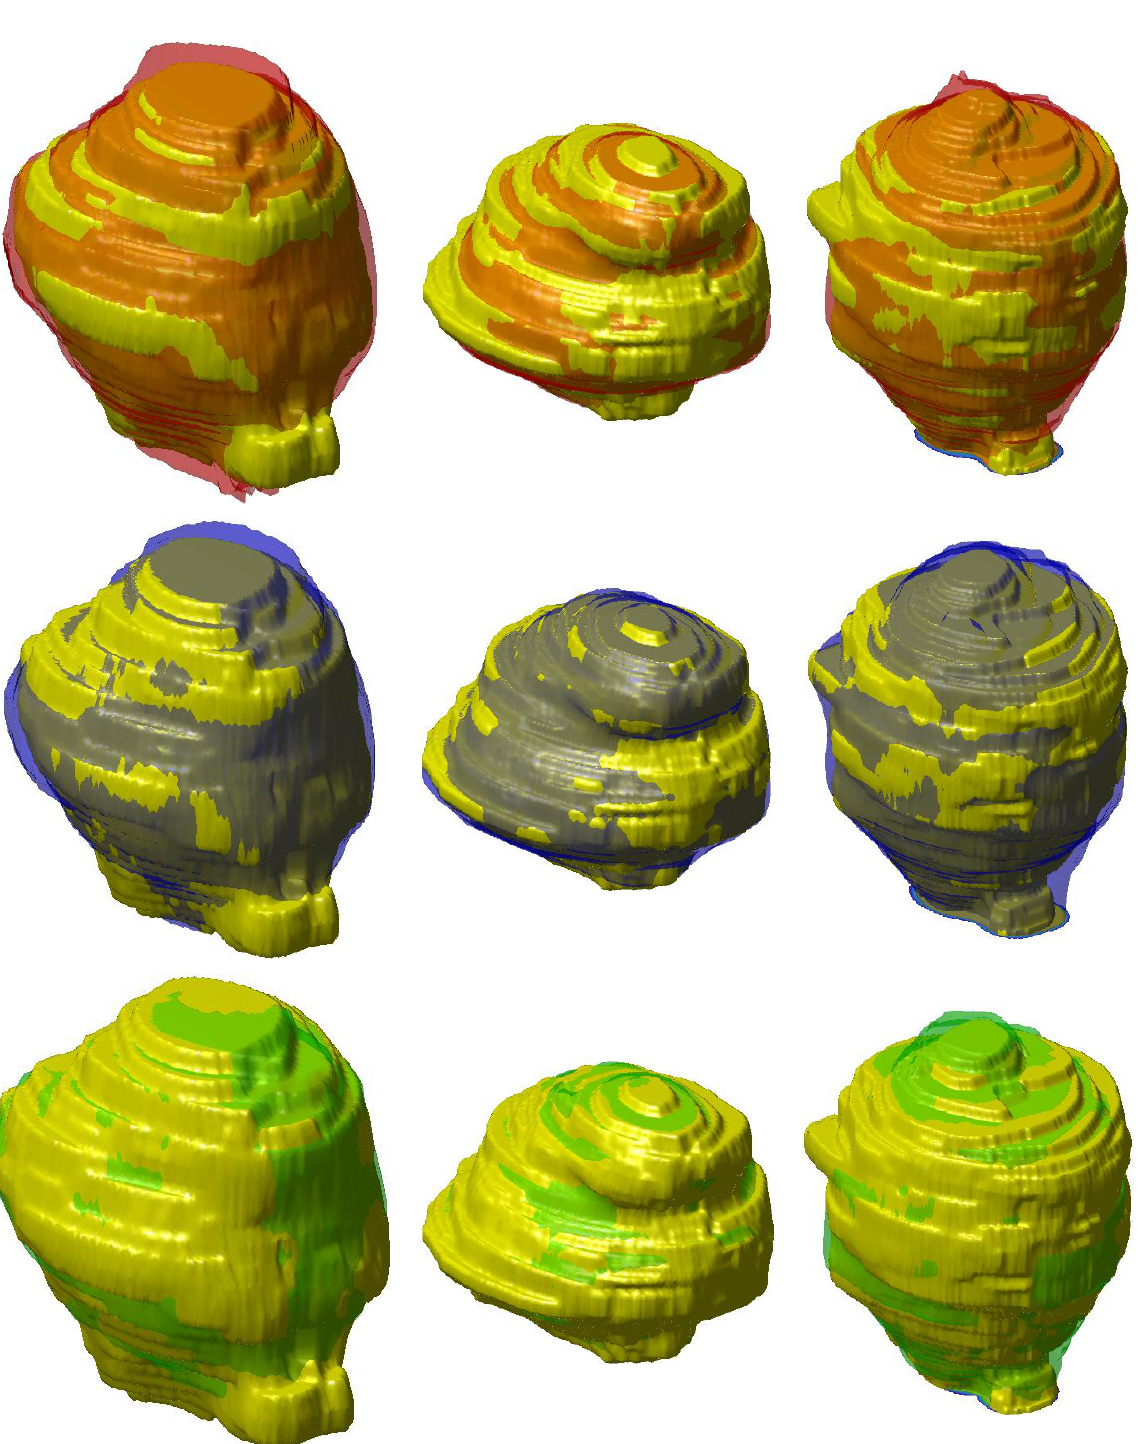
Figure 5. Comparison of 3D segmentation of prostate (patients #7, #74, and #84) for each column using the three Net architectures. The manual segmentation (yellow), ENet (red), ERFNet (blue), and U-Net (green) are superimposed.